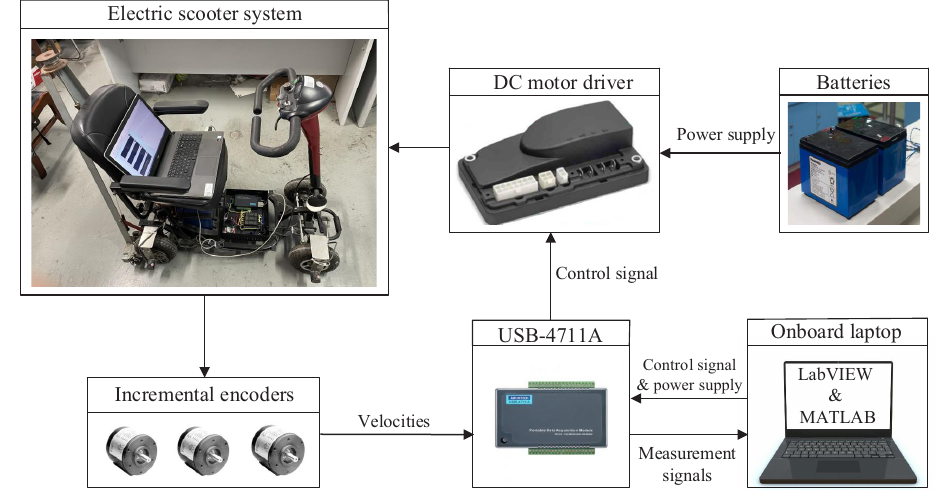
Figure 8. Diagram of experimental platform